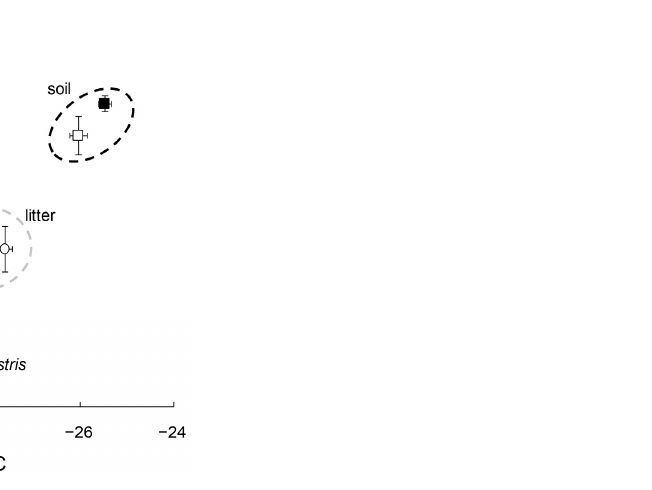
Figure 2. Average δ 13 C and δ 15 N in Betula spp. leaves ( △ , ▲ ) and Pinus sylvestris needles ( ◇ , ◆ ), in litter ( ○ , ● ) and soil humus horizon ( □ , ■ ) in the habitats of the Ilmen State Reserve (white symbols) and near the Karabash copper smelter (black symbols). Vertical and horizontal lines correspond to the standard error (SE) bars. The dotted lines show the ranges of δ 13 C and δ 15 N values in the same objects in the absence and presence of heavy metal pollution.